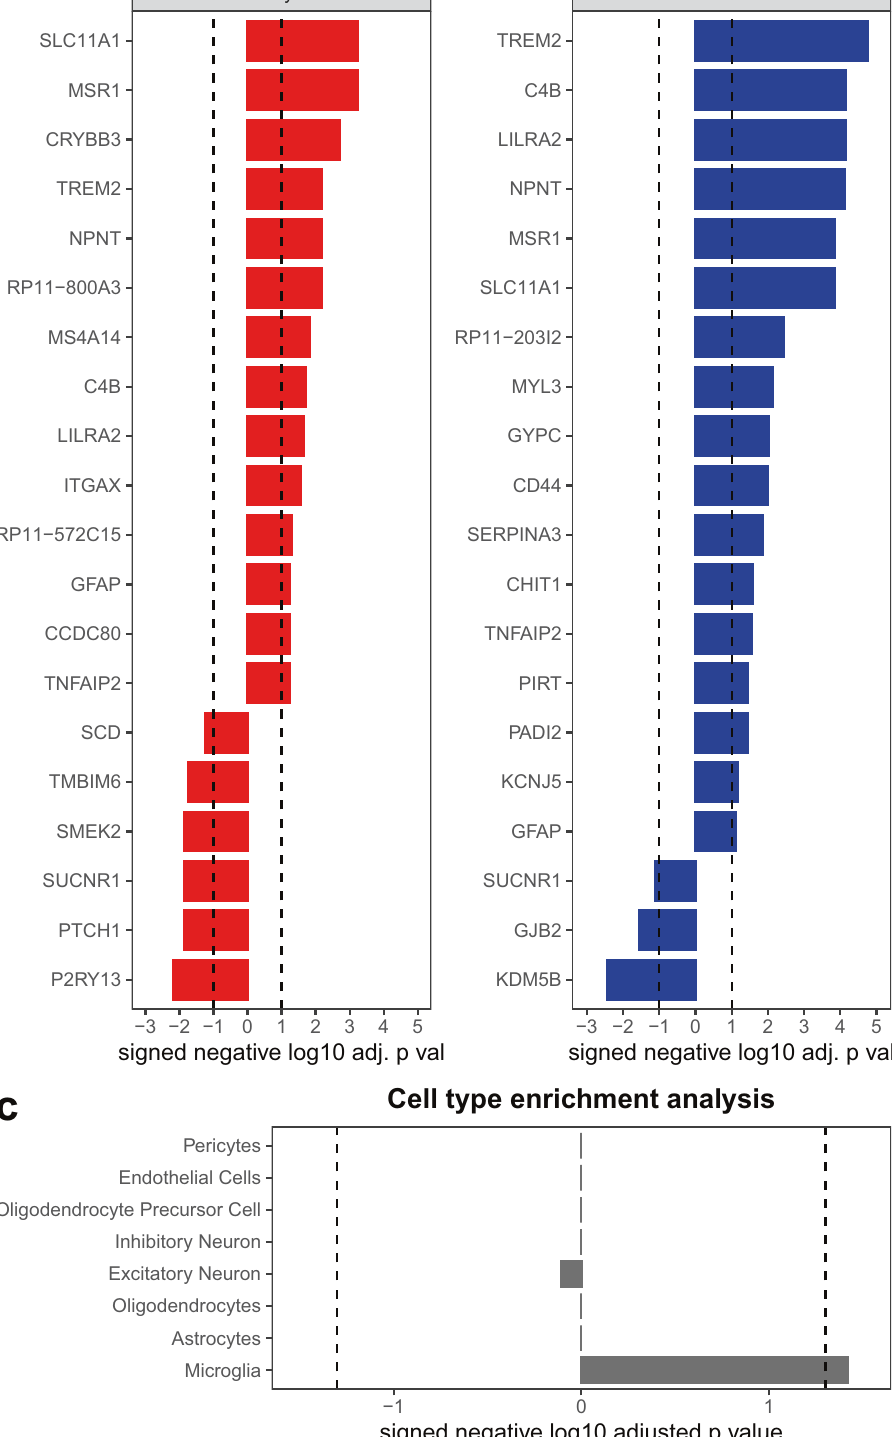
Fig. 2 A restricted set of genes correlate with AD pathology in NPH biopsies. Shown are the top 20 genes that correlate with β -amyloid ( a ) and tau ( b ) burden in NPH biopsies (FDR adjusted using the Benjamini – Hochberg procedure across all genes in the transcriptome — dotted line is FDR = 0.1; see Supplementary Data 1 for the full list; all correlations are Spearman ’ s correlations with two-sided signi fi cance). c A two-sided Fisher ’ s exact test con fi rmed that microglia-speci fi c genes are overrepresented among the genes that individually passed our FDR threshold using human single-nucleus RNA-seq data 21 ( c shows Bonferroni adjusted p values; dotted line = p value of 0.05; See Supplementary Data 1 for numerical